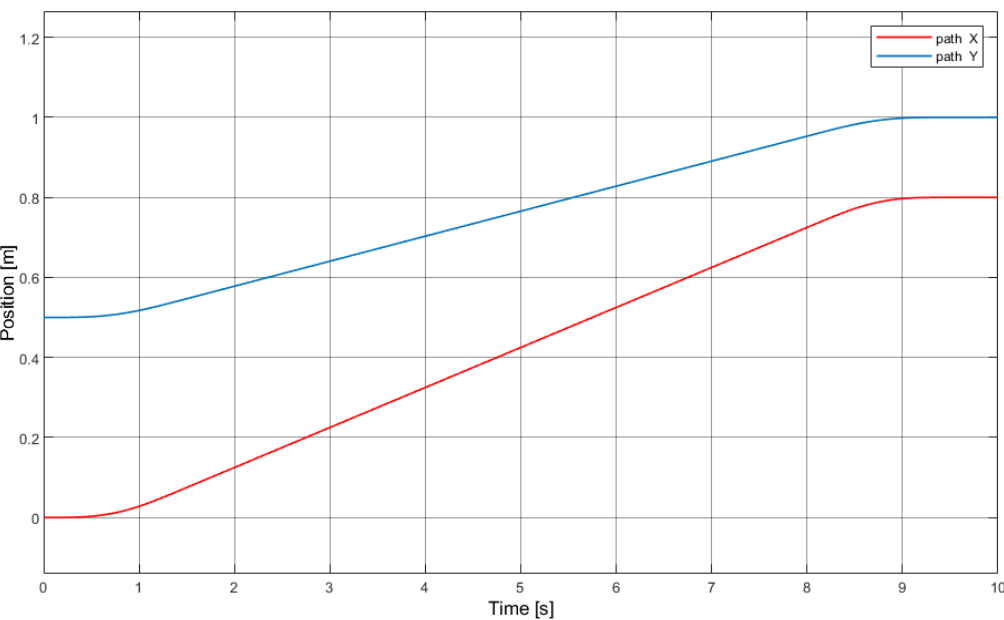
Figure 4. Trajectory for position using 6-1-6 polynomials for the planar CDPR.